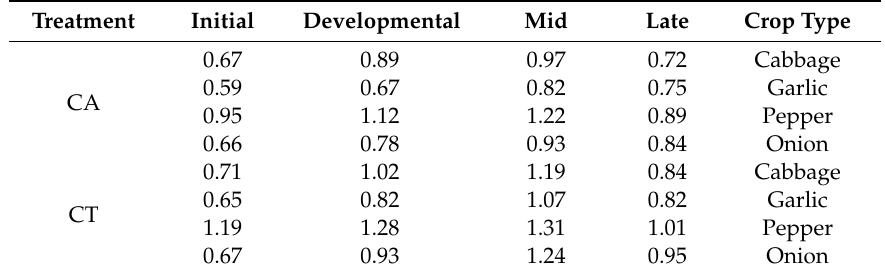
Table 4. Average crop coe ffi cients of cabbage in Robit, garlic, onion, and pepper in the Dangishta experimental site,